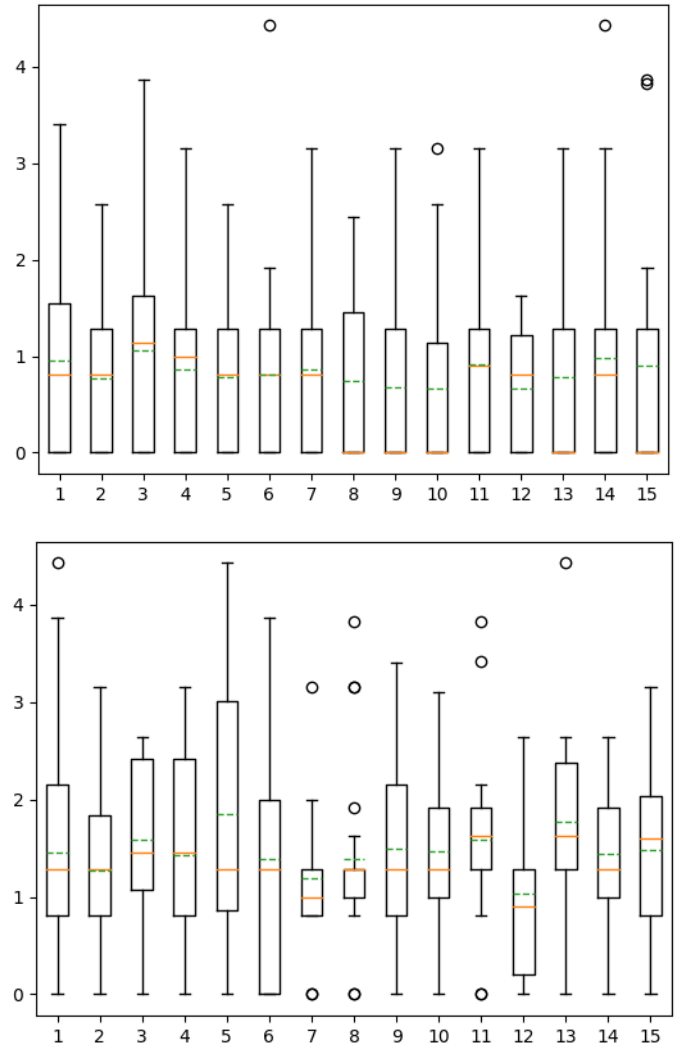
Figure 7. Boxplots of the distances between participant choices and true location of the reference by index until the 15th answer of participants for variant 1 ( top ) and 2 ( bottom ) of the experiment. The cues mentioned by participants include intonation, tonic accent, speech rate, and